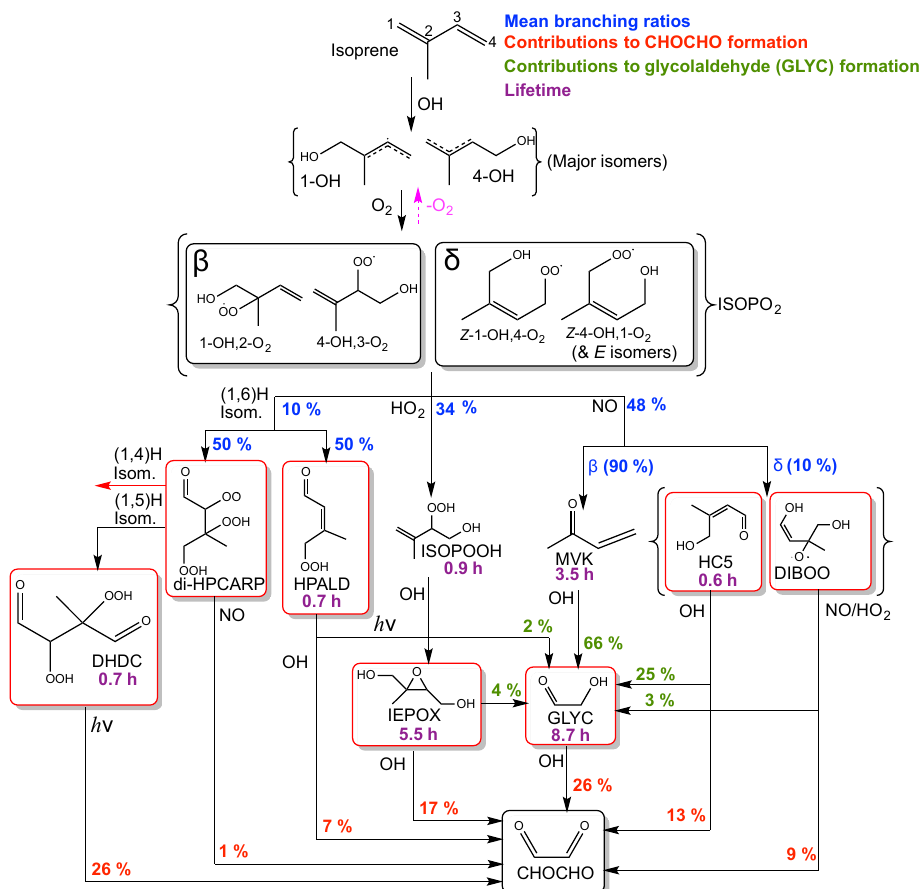
Figure 1. Pathways for glyoxal (CHOCHO) formation from isoprene oxidation in GEOS-Chem as implemented in this work. Only species relevant to CHOCHO formation are shown. Branching ratios, species lifetimes, and contributions to glyoxal and glycolaldehyde (GLYC) formation from each boxed species are mean values over the southeast US (96.25–73.75 ◦ W, 29–41 ◦ N) during the SENEX campaign (1 June– 10 July 2013). Species lifetimes are shown for an OH concentration of 4 × 10 6 moleculescm − 3